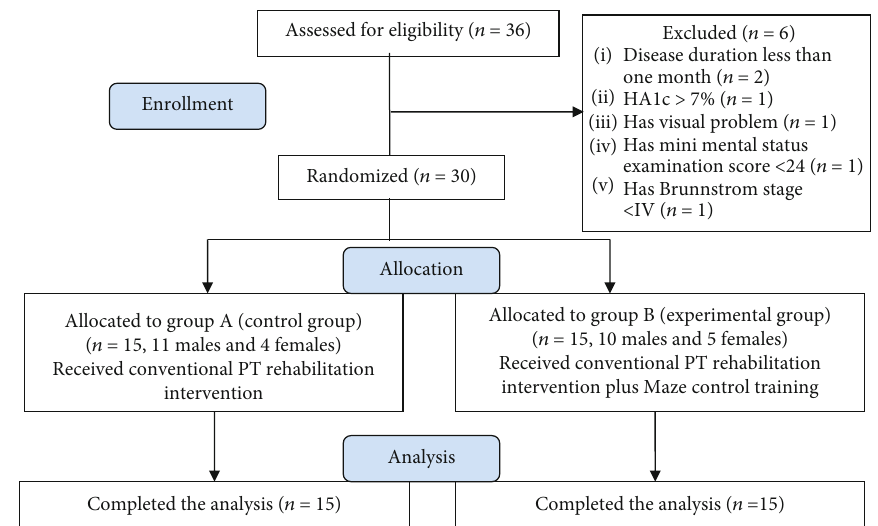
Figure 1: Flow chart of the participants.